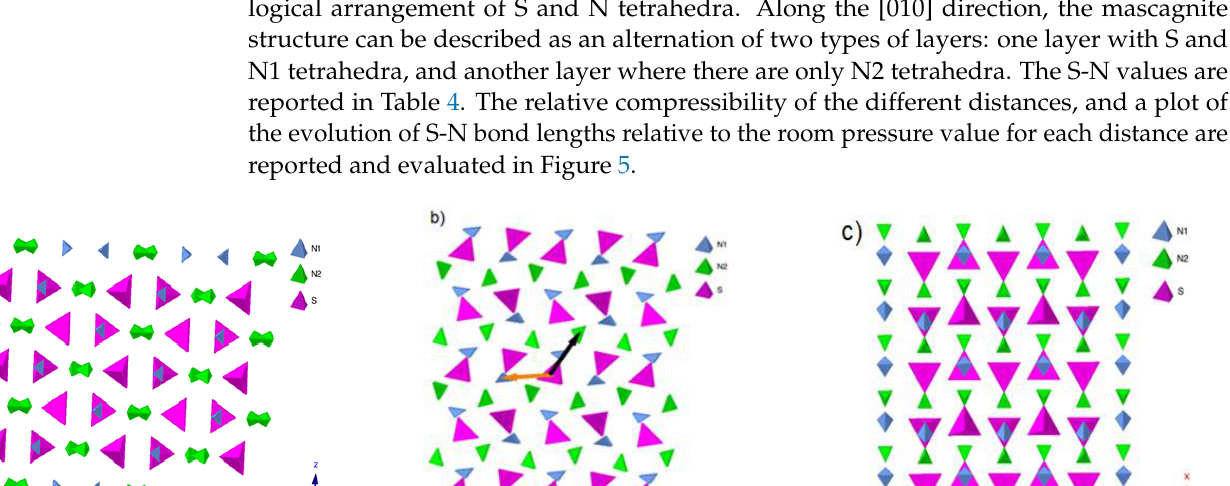
* principal component along the x axis, ** principal component along the y axis.